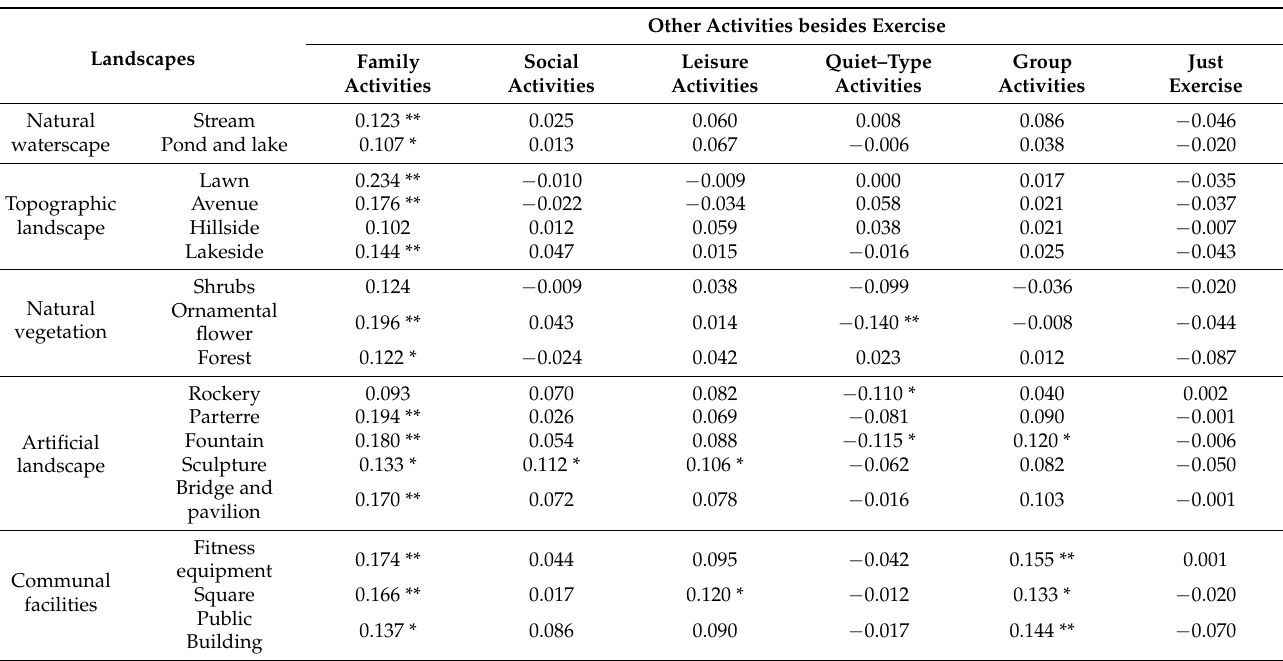
Table 6. Correlation between the choices of other types of activities other than exercise and visual landscape preferences.